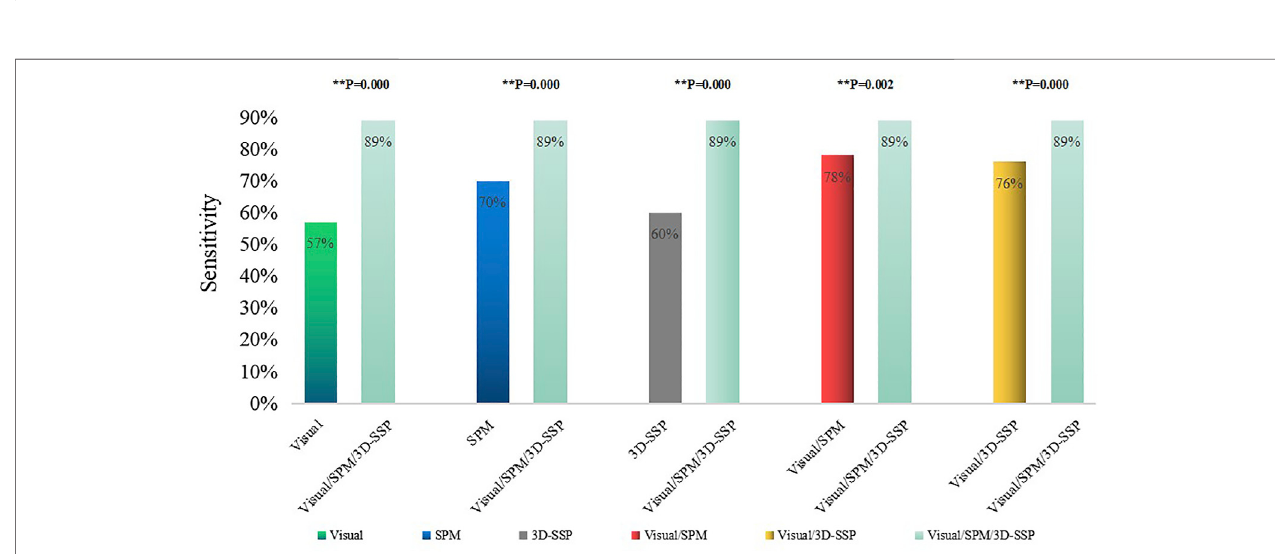
FIGURE 4 | Comparison of the sensitivities of single method, two combined methods, three combined methods (** p < 0.05, ## p > 0.05). Visual/SPM/3D-SSP, Visual assessment combined SPM and 3D-SSP.